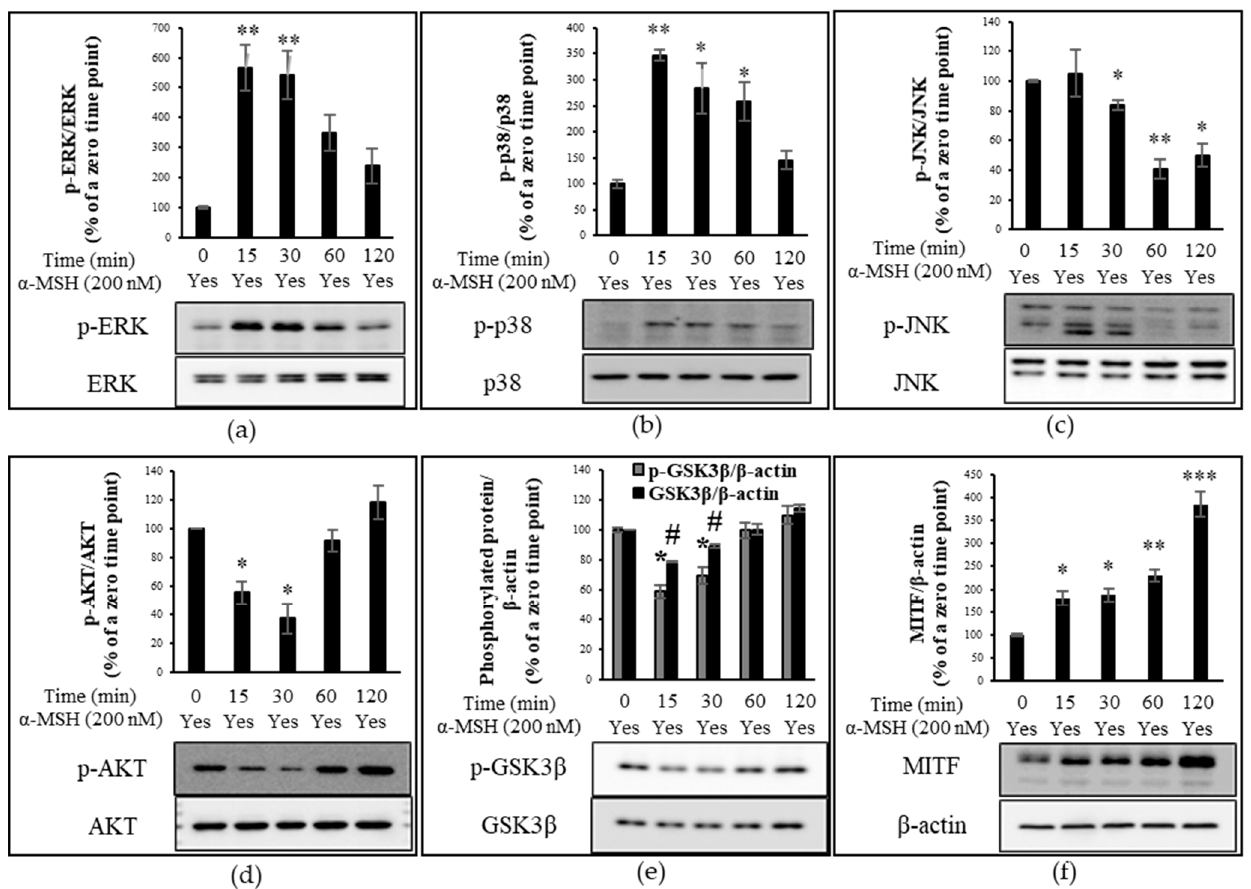
Figure 4. Proteins detected by immunoblotting. Time-course analysis of protein phosphorylation level (percentage ratio of phosphorylated protein to total protein) or protein expression level (percentage ratio of total protein to β -actin) in α -MSH-treated B16F10 cells. The relative phosphorylation level of extracellular signal-regulated kinase (ERK), p38, and JNK as well as the protein expression level of microphthalmia-associated transcription factor (MITF), glycogen synthase kinase 3 β (GSK3 β ), and phosphorylated-GSK3 β (p-GSK3 β ) are compared to those at time zero (control). ( a ) The relative phosphorylation of ERK. ( b ) The relative phosphorylation level of p38. ( c ) The relative phosphorylation level of JNK. ( d ) The relative phosphorylation level of AKT. ( e ) The expression level of p-GSK3 β and GSK3 β . ( f ) The relative protein expression of MITF. The data were presented as the mean ± standard deviation of three independent experiments; * p < 0.05, ** p < 0.01, *** p < 0.005, # p < 0.05 compared with α -MSH only.